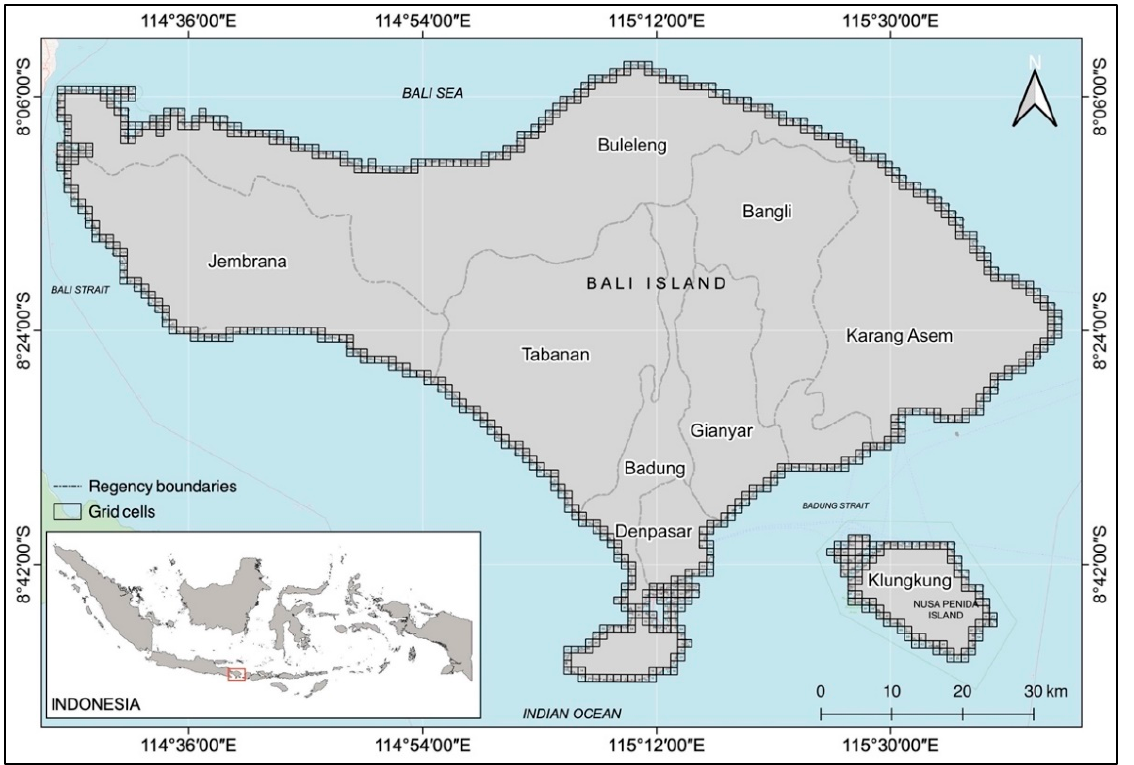
Figure 1. The study area with grid cells along the shoreline. Bali Island is dominated by a slope greater than 15%, which is predominantly found in the central section. This covers the mountain area that stretches from west to east, through Jembrana, Tabanan, Klungkung, Bangli, and Karangasem regencies, while a terrain slope of less than 15% is found in the Denpasar, Gianyar, and Badung regencies. There are five main types of soil, i.e., alluvial, regosol, grey-brown andosol, latosol, and Mediterranean. Bali’s climate is tropical. The wet season occurs between November and April, leaving May through October typically dry. The tides are of the mixed semidiurnal type, and are influenced by the Indian